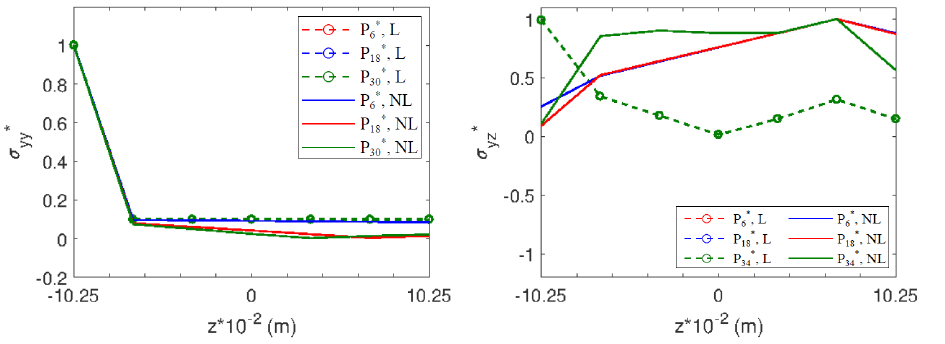
= − 3.3 − 4 , P ∗ = − 2.9 − 3 , 6 18